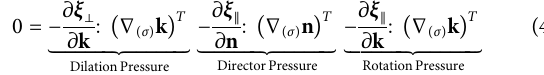
Figure 2C is the anchoring parameter space μ 4 − μ 2 , superposed with the computed surface wrinkling pro fi les h ( x ). The wrinkling parametric space is characterized by a resonant line (thick red line) and a damping line (thin black line). Maximal two-scale wrinkling occurs above and below the resonant line. Two-scale wrinkling only arises in quartic anchoring models when the anchoring coef fi cients have opposite signs ( − +) or (+ − ). Figure Figure2d) shows representative two-scale wrinkling pro fi les and de fi nes the large ( h 0 )and small ( h 2 ) scales of the amplitudes. The solution of the shape equation and analysis (Rofouie et al., 2018) reveals the presence of novel quadratic scaling laws for two-scale h 0 , h 2 wrinkling: